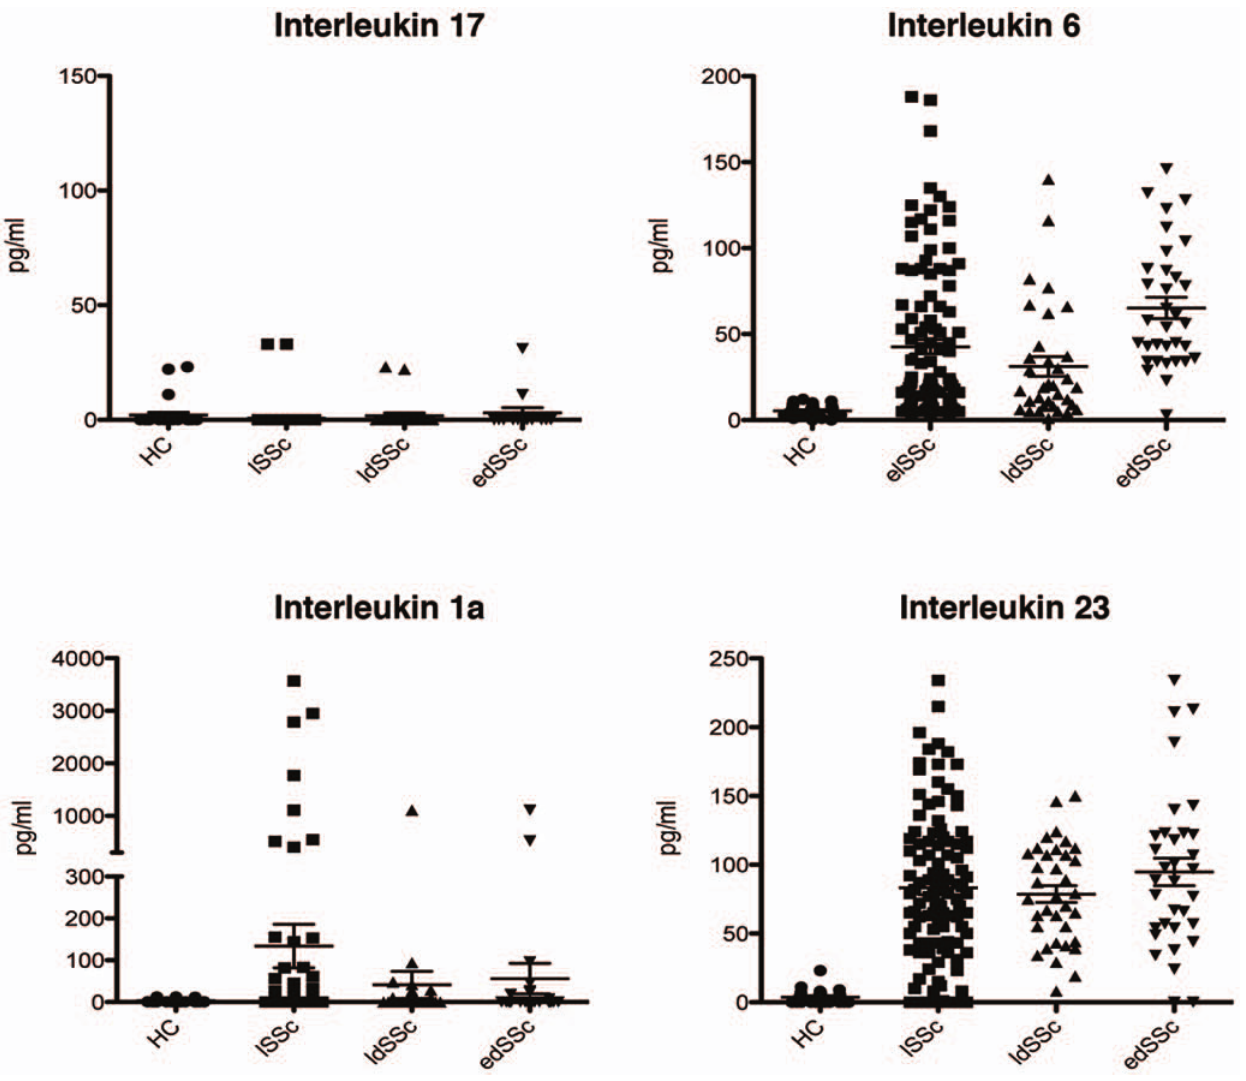
Figure 3. Increased level of Th17 inducing cytokines in the circulation of SSc patients. Panel A depicts the presence of IL-17 in the circulation of SSc patients and healthy controls. Panel B, C and D represents the levels of IL-6, IL-1 a and IL-23, respectively. The circulating levels of IL- 17, IL-1 a and IL-23 was measured by ELISA whereas IL-6 was studied by Bioplex assays.